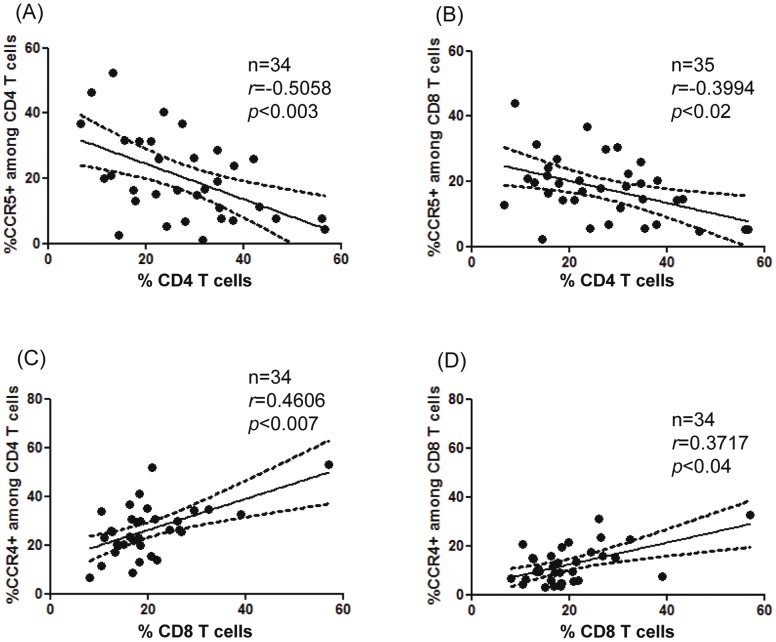
Relationship between chemokine receptor changes with frequency of peripheral T cells.Each acute or convalescent DENV-patients are represented. Correlations were explored using Spearman’s rho test. Statistically significant r values and P are given above the figures.